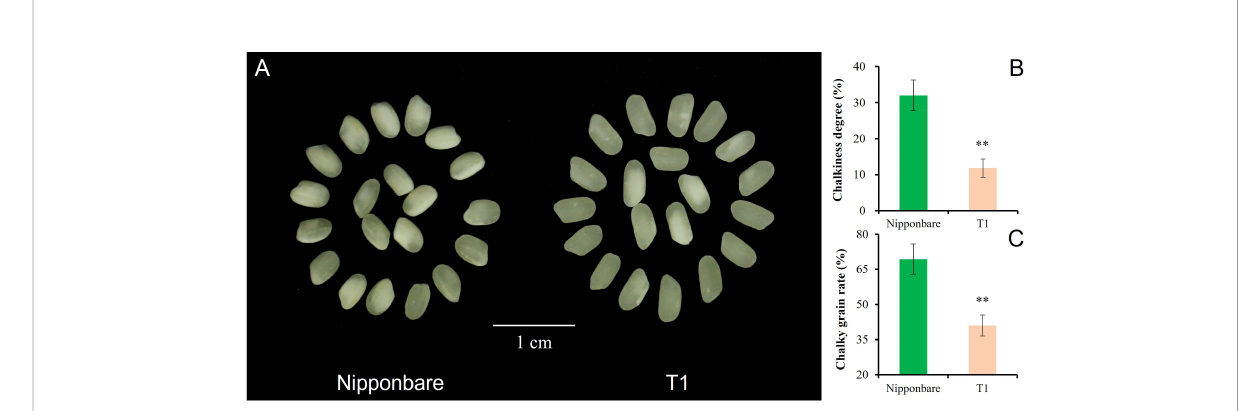
FIGURE 5 Chalkiness comparison of Nipponbare and T1. (A) Polished grain of Nipponbare and T1; (B) Chalkiness degree (%) of Nipponbare and T1; (C) Chalky grain rate (%) of Nipponbare and T1. **, signi fi cant at.01 level ( P <